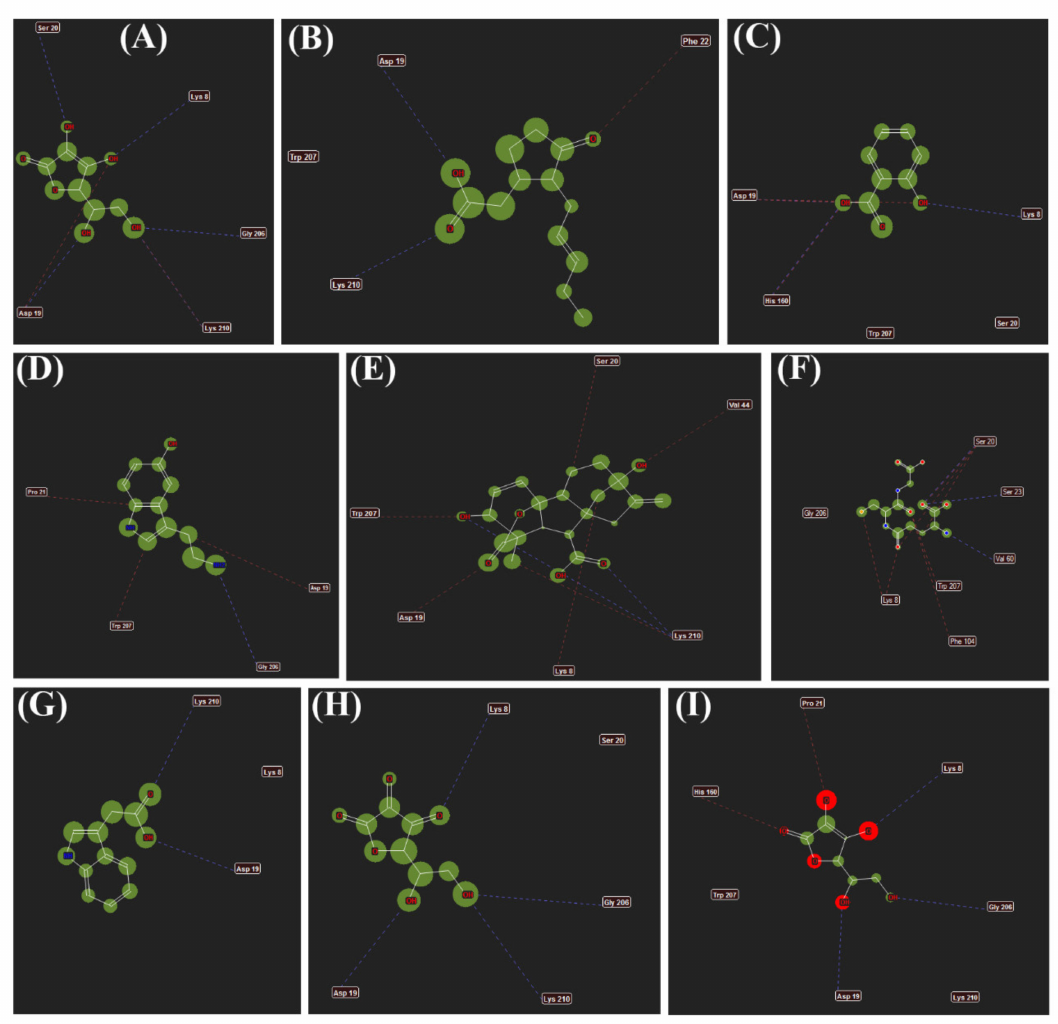
Figure 6. Interactions between the ligands and the active site of Os DHAR. ( A ) AsA; ( B ) JA; ( C ) SA; ( D ) 5-HT; ( E ) GA3; ( F ) GSH; ( G ) IAA; ( H ) DHA and ( I ) MDHA. The dotted lines represent hydrogen bonding and stearic interactions between the ligands and the amino acid residues